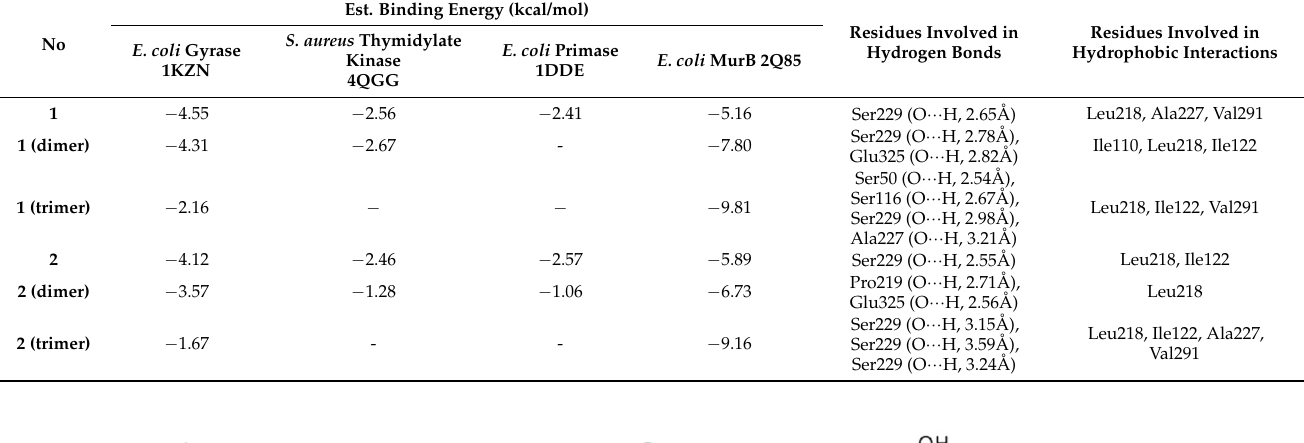
Table 4. Molecular docking binding affinities to antibacterial targets.